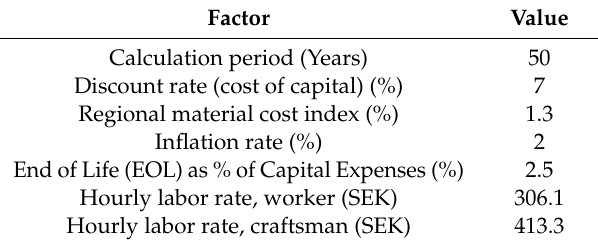
Table 3. Life cycle cost (LCC) calculation parameters.